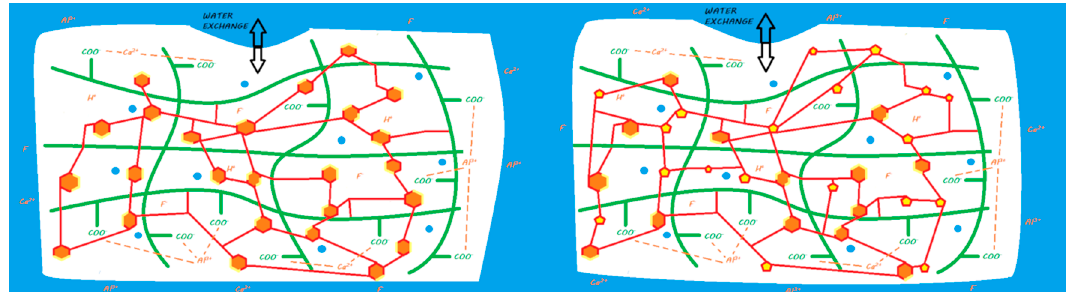
Figure 10. Ion release from Vitremer (left) or Ketac Nano (right) once they are in contact with a moist environment (i.e., oral environment). When the powder and liquid (or pastes for Ketac Nano) are mixed, the acid–base reaction is initiated, the setting of the material begins. Once the FAS fillers are partially attacked, a silicic gel partially forms on the FAS filler surface. The released calcium and aluminum ions are able to form ionic bonds with ionized carboxylic groups. Fluoride ions are also released. A second reaction involving resin polymerization occurs during mixing for Vitremer (chemopolymerization) or during light curing for Ketac Nano. Monomers can copolymerize with silanated FAS fillers and other monomers for both materials and silanated unreactive fillers for Ketac Nano. At the end of the reaction, two interconnected networks are obtained with covalent links between both due to the modified polyacrylic acid (Vitrebond copolymer). In water, calcium, aluminum, and fluoride ions (and eventually other ions) are able to be exchanged with the oral